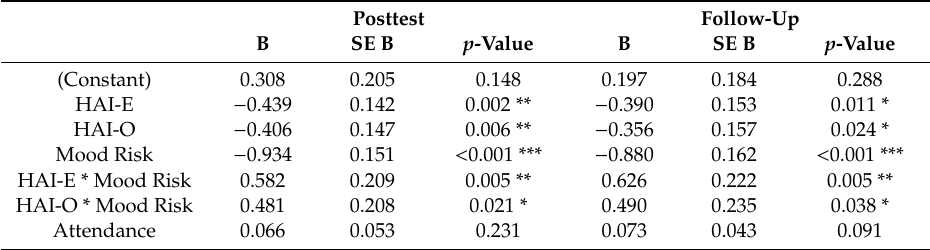
Table 1. Regression analyses modeling moderation e ff ects of mood risk and treatment condition on students’ WILL towards learning and study strategies. Posttest Follow-Up